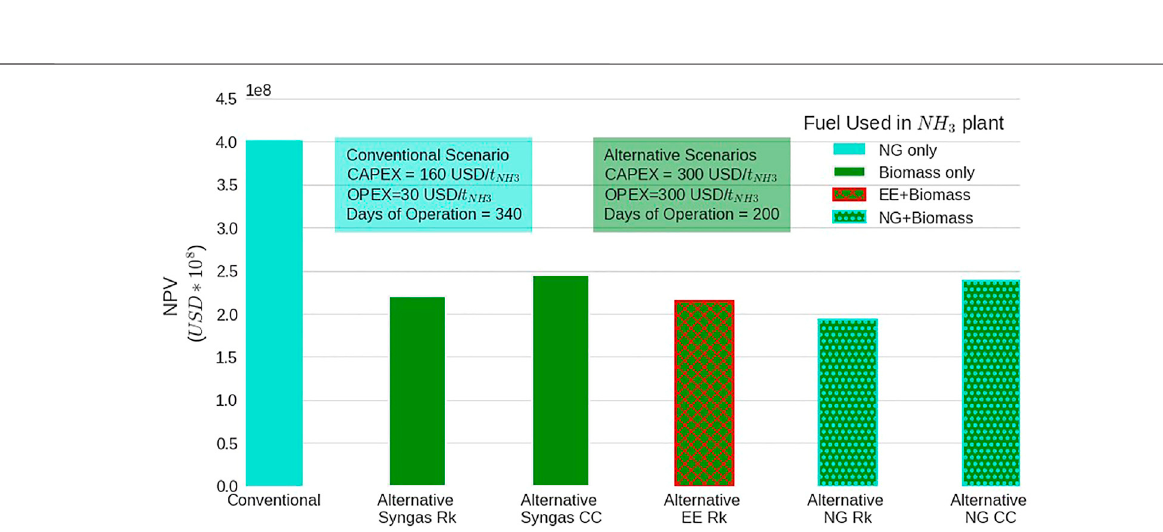
FIGURE 9 | Net present value (NPV) for the conventional and integrated ammonia production scenarios without considering carbon taxes. Rk, Rankine cycle; CC, combined cycle; NG, natural gas; EE, electricity. “ Syngas ” represents the production routes that only consume bagasse and produce their own utilities consuming a fraction of the syngas